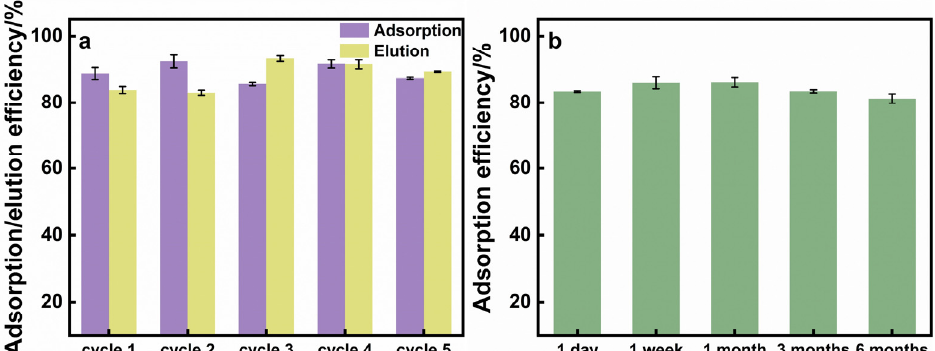
Figure 8. ( a ) The adsorption and elution efficiency of GST by GPG for 5 repeated adsorption–elution cycles. GST solution: 1.0 mL, 100 mg L − 1 ; Adsorption time: 30 min; Elution time: 20 min; Mass of adsorbent: 1.0 mg. ( b ) Adsorption efficiency of GST onto GPG composite under different storage time. GST solution: 1.0 mL, 100 mg L − 1 ; Adsorption time: 30 min; Elution time: 20 min; Mass of adsorbent: 1.0 mg.